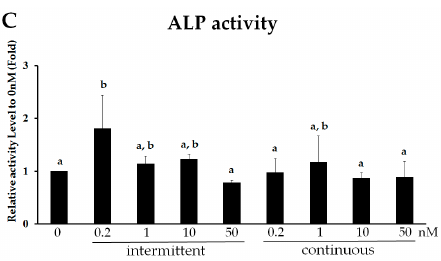
Figure 2. Intermittent parathyroid hormone (PTH) (1–34) treatment increased osteoblast activity during osteogenic differentiation of human mesenchymal stem cells (hMSCs). ( A ) Alkaline phosphatase (ALP) staining of hMSCs at day 7 of osteogenic induction and after treatment with 0.2, 1, 10, and 50 nM PTH (1–34) using two modalities: intermittent: 2 h per day for 7 days; and continuous: every 2 days for 7 days. Cells with ALP activity stained blue; ( B ) Alizarin Red staining for mineralized deposits in hMSCs at day 7 of osteogenic differentiation and after intermittent and continuous treatment with various concentrations (nM) of PTH (1–34); ( C ) Relative ALP activity in hMSCs at day 7 of osteogenic differentiation and after intermittent and continuous treatment with various concentrations (nM) of PTH (1–34). The relative activity in the samples was determined and compared to that of the no PTH (1–34) treatment control group and normalized to the total protein concentration (units/mg). Data are represented as mean ± SD ( n = 3). Statistical data analysis was performed by performing one-way ANOVA with Tukey’s post-hoc tests. Different letters represent significant differences between groups; those with the same letters were not significant ( p < 0.05).